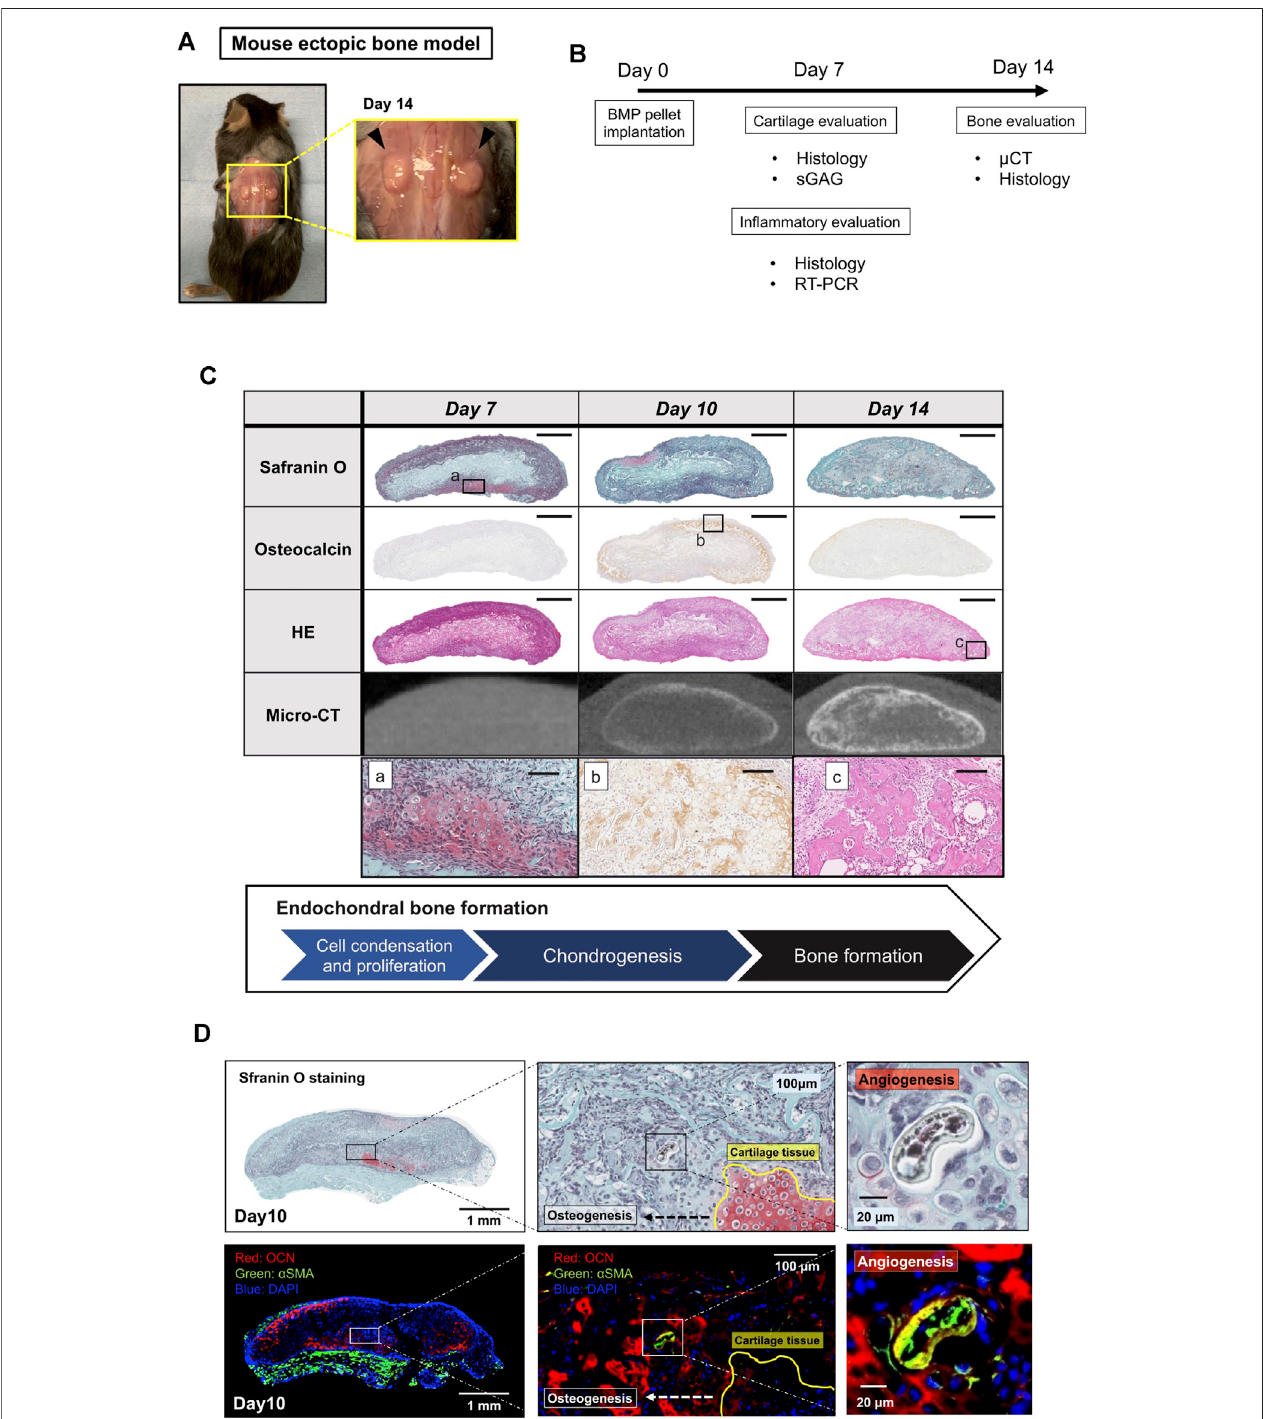
FIGURE1| AmousemodelofBMP-2-inducedectopicboneformation. (A) BMP-2pellets14 daysafterimplantation. (B) Theexperimentoutline. (C) Histologyand μ CTimages ofthe BMP-2pellets on Days 7, 10,and 14(scale bar = 1 mm or 100 μ mfor whole viewand themagni fi ed view, respectively). (D) TheBMP-2pellet onDay 10. Cartilage tissue was replaced by new bone (OCN, red) and vasculature ( α SMA, green).